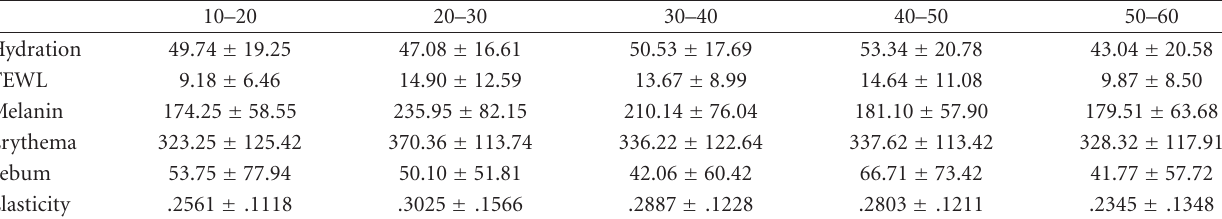
Table 2: The mean and standard deviation of skin hydration, TEWL, melanin index, erythema index, sebum, and elasticity in 5 age